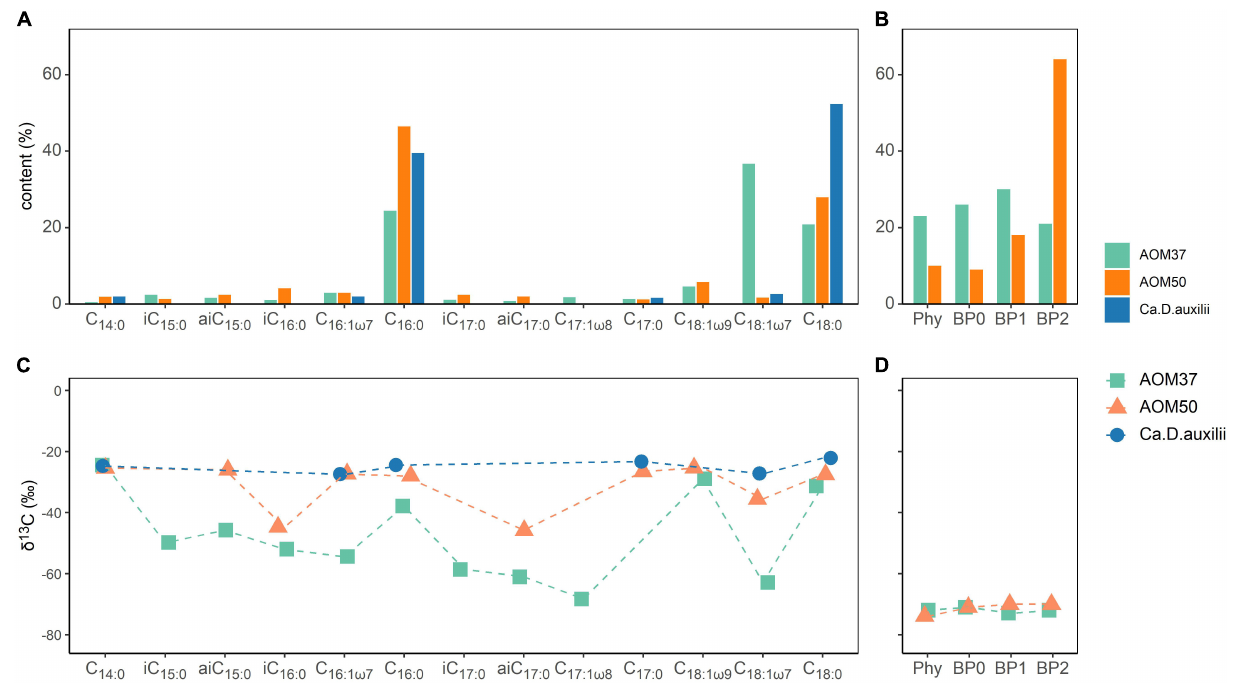
FIGURE 1 | Bacterial and archaeal lipid patterns (A,B) and their δ 13 C values (C,D) in the original cultures AOM37 and AOM50 and the isolated bacterium Ca . D. auxilii. Phy and BP data are derived from total lipid extracts.